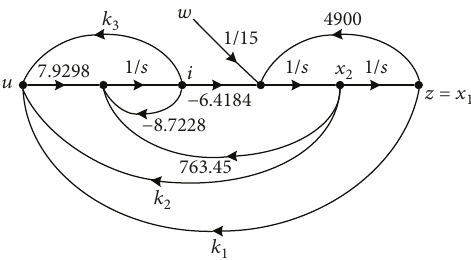
Figure 8: Signal fl ow diagram of the system with state